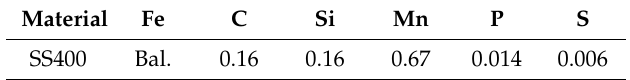
Table 3. Chemical composition of welding wire ER4043 (wt %).